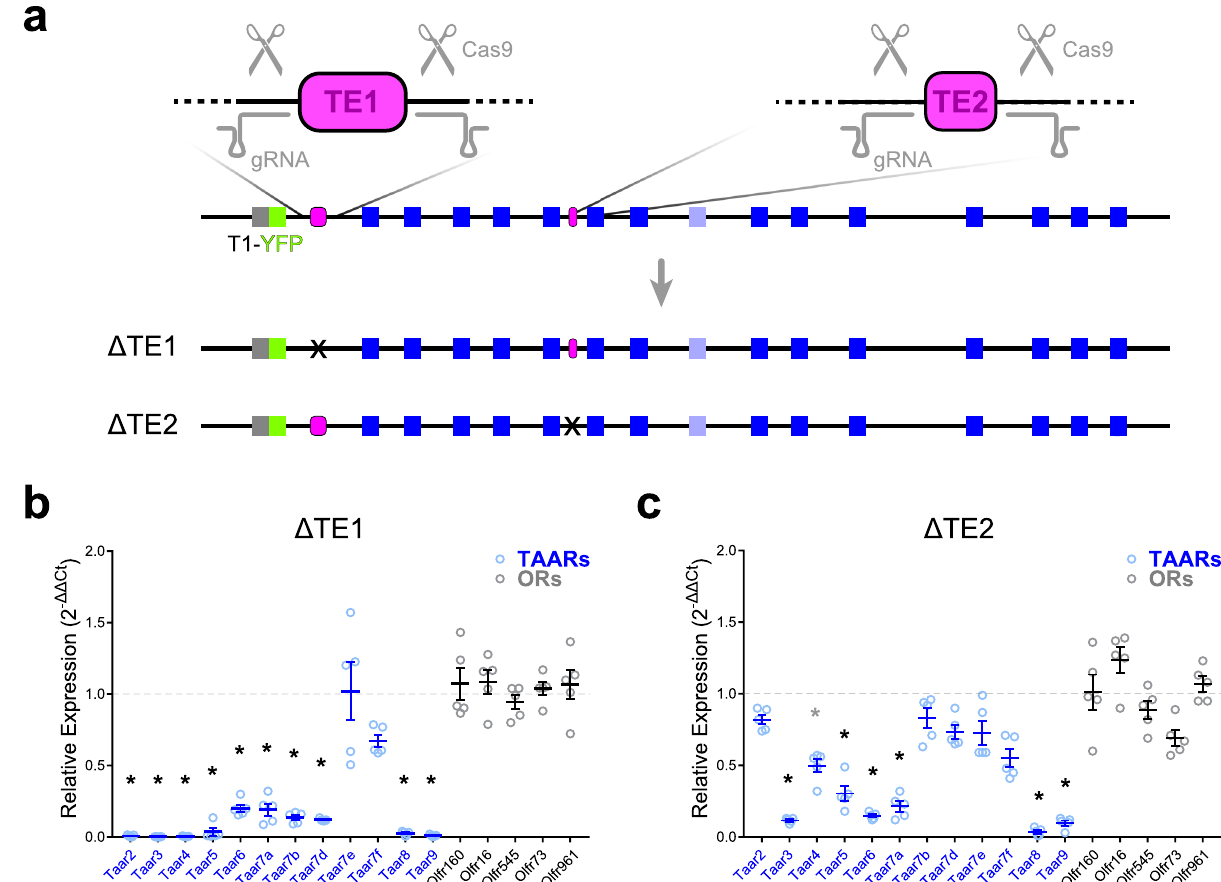
Fig. 8 TAAR enhancers function cooperatively. a Generation of single T-element deletions via CRISPR. Locations of gRNAs (gray) are shown relative to TE1 and TE2 (magenta). The individual Δ TE1 and Δ TE2 mutations were generated on a chromosome harboring a previously targeted Taar1-YFP allele (green). Bottom, diagram of Δ TE1 and Δ TE2 in cis with Taar1-YFP. Deletion is marked (X). b , c Relative fold expression of TAAR (blue) and control OR (gray) genes measured using qPCR (2 - ΔΔ Ct method) from olfactory mucosa from Δ TE1 and Δ TE2 mice. Error bars indicate mean ± SEM. Taar8 primers amplify all 3 family members. n = 5 mice per genotype. * p < 0.01; one-way ANOVA, Dunn – Š idák correction for multiple